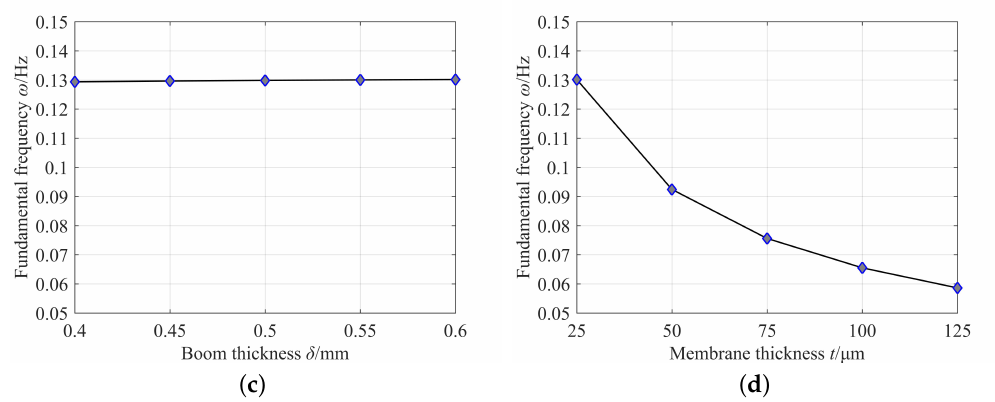
Figure 10. Effect of parameters: ( a ) effect of mechanism height, ( b ) effect of cable tension, ( c ) effect of boom thickness and ( d ) effect of membrane